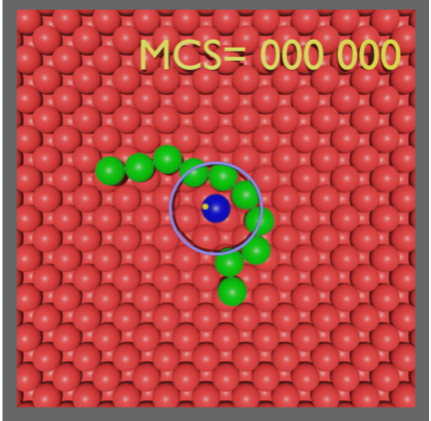
Figure 1. Illustration of a random initial configuration of a ten-monomer polymer (green) adsorbed to an FCC (cid:104) 100 (cid:105) crystal (red) substrate. The midpoint of the segment defined by its central monomers is tangent to a circle of unit radius and centered on the (blue) impurity. The escape, or stop, condition is defined by the midpoint moving past a distance, r c , scaling with the size of the polymer, illustrated here by the (purple) ring. The (yellow) dot represents the position of the center of mass of the